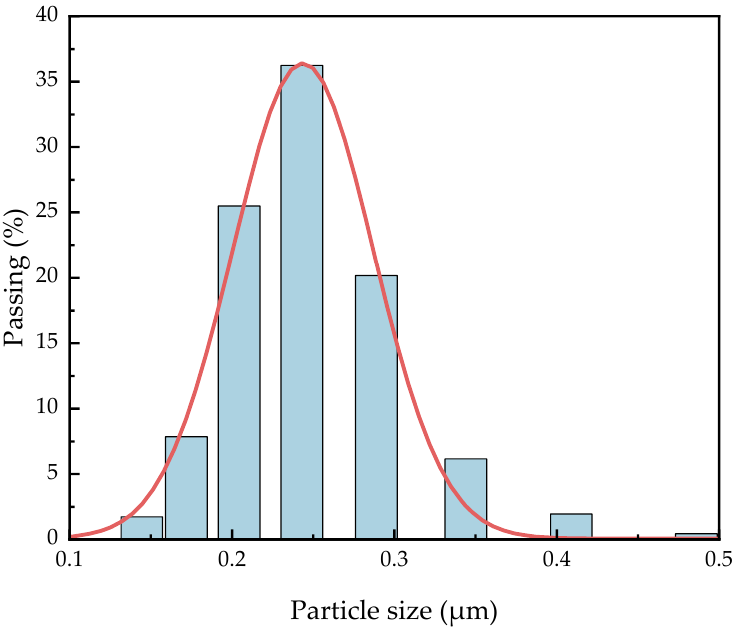
Figure 3. Particle size distribution of C 8 H 18 -Al nanoparticles.